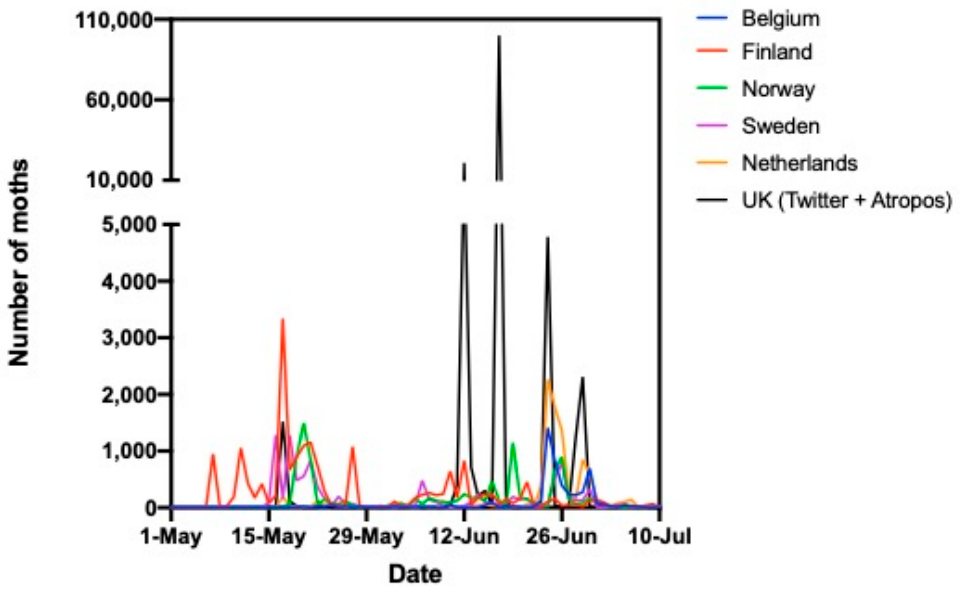
Figure 5. Comparison of peaks in abundance of P. xylostella in different European countries in 2019 (using numbers of moths seen per day by citizen scientists in each country).